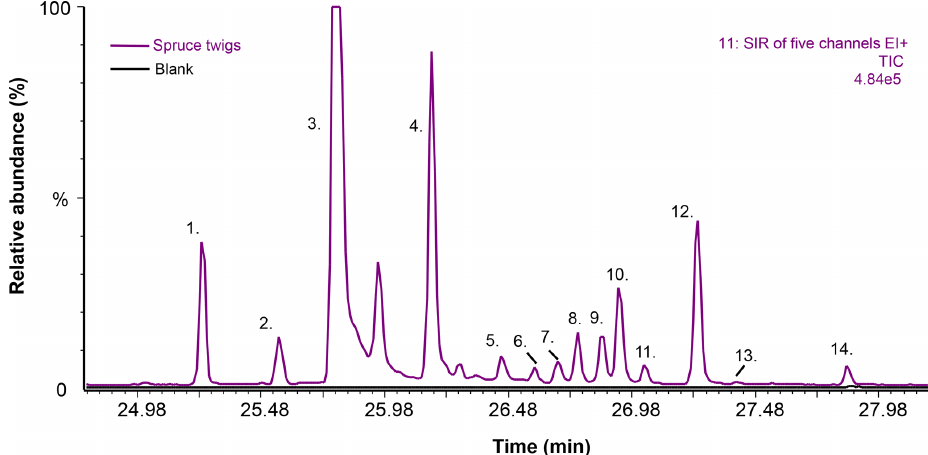
Figure 7. Selected ion recording (SIR) chromatograms from the TD–GC–MS1 analysis of spruce twigs and blank dynamic headspace sorbent tube samples (sampling at 60 ◦ C for 20min at a flow rate of 100mLmin − 1 ). The five m/z ions included in the SIR were m/z 93, 229, 257, 272 and 275. The TIC is scaled for presentation purposes; peak number 3 is not shown in full height in order to visualise the other peaks more clearly. Peak identification is as follows. 1. Rimuene (C 20 H 32 , DT). 2. Unknown (C 20 H 32 , DT). 3. Cembrene (C 20 H 32 ,